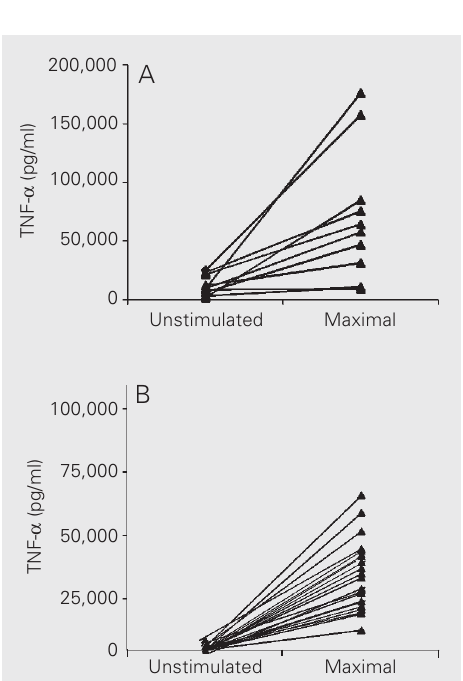
Figure 2. Induction of maximal tumor necrosis factor alpha (TNF- α ) production by maximal or submaximal LPS concentra- tions in 24-h whole blood cul- tures of healthy controls and malnourished children. Data are the % of total subjects in each group presenting maximal TNF- α production at the highest (2000 ng/ml) LPS concentration tested (open columns, controls, N = 18; filled columns, malnour- ished subjects, N = 11) or at lower (0.002-200 ng/ml) stimu- lus concentrations.